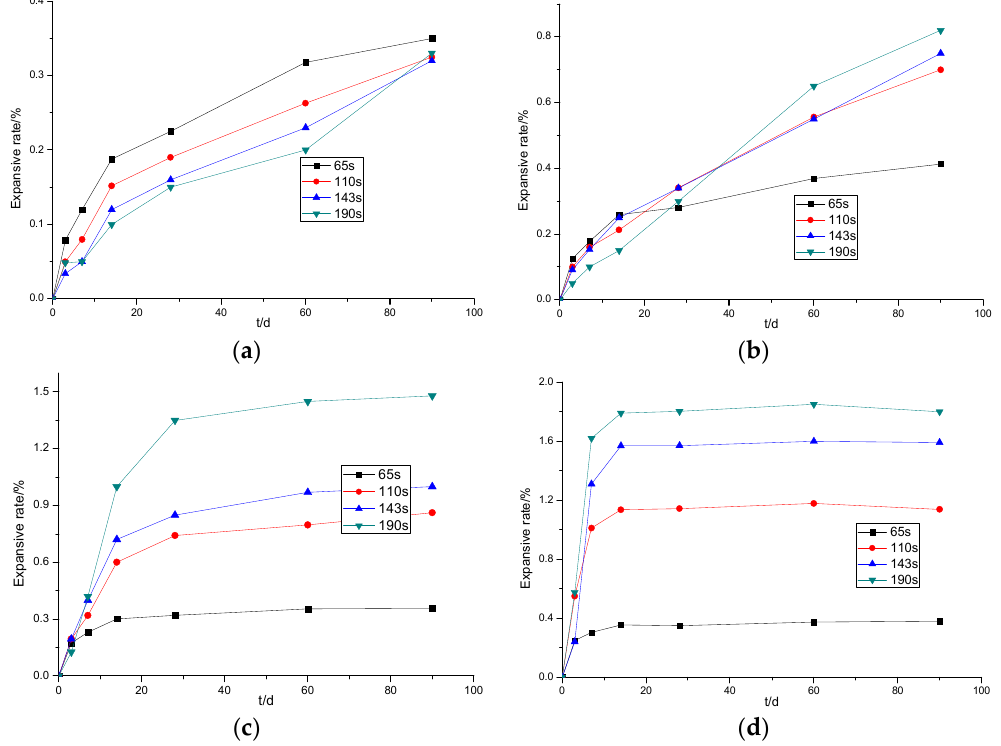
Figure 5. The expansion curves of cement paste mixed with MgO (10%) of different activities at different temperatures: ( a ) 20 °C; ( b ) 38 °C; ( c ) 60 °C; ( d ) 80 °C.